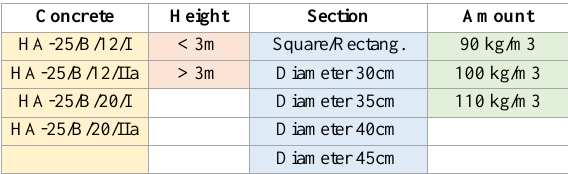
Table 2. Variables that establish the type of pillar .